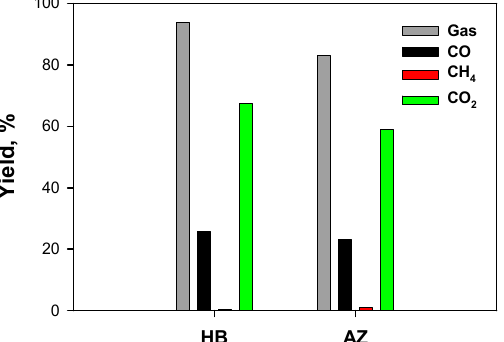
Figure 8. Gas yield and yields to CO, CH 4 , and CO 2 as a function of the solvents mixture during steam reforming on 5 Ni at 720 °C and atmospheric pressure; gas-phase feed composition: Solvent/H 2 O/O 2 /N 2 = 0.7/6/0.8/92.5.